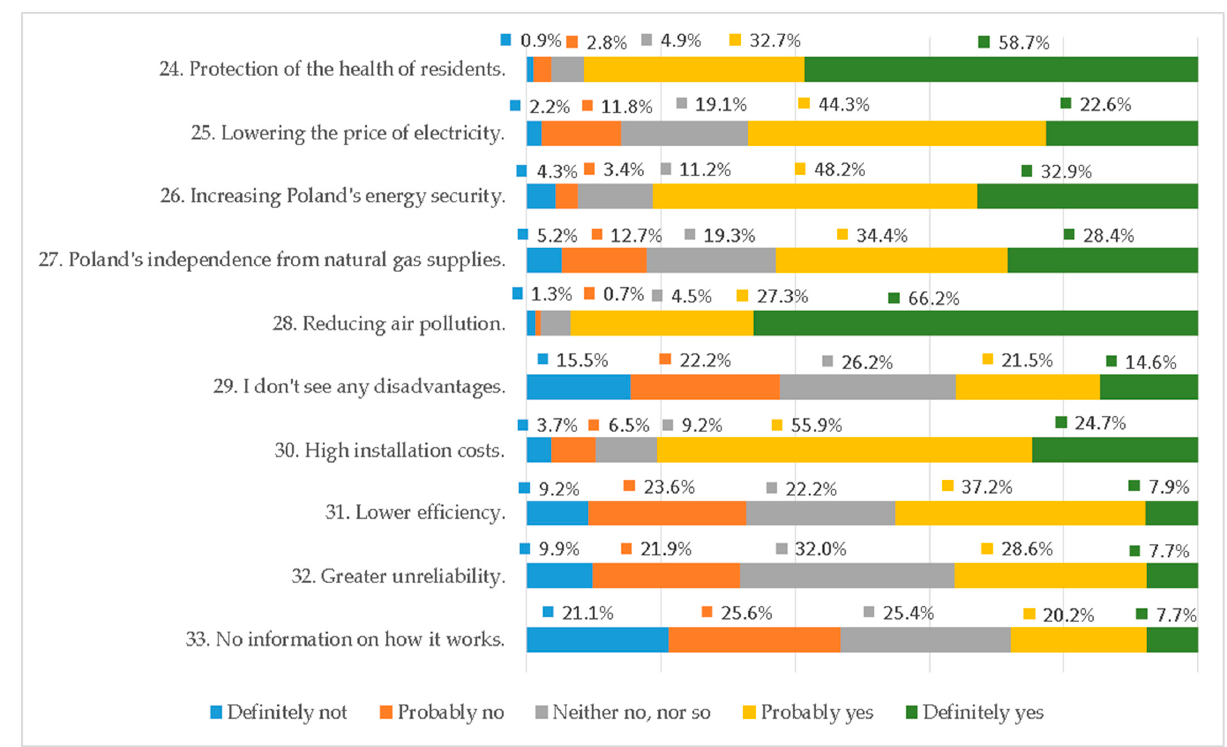
Figure 3. The structure of assessments of theses diagnosing the perception of advantages and disadvantages of energy production from renewable sources by adolescents.